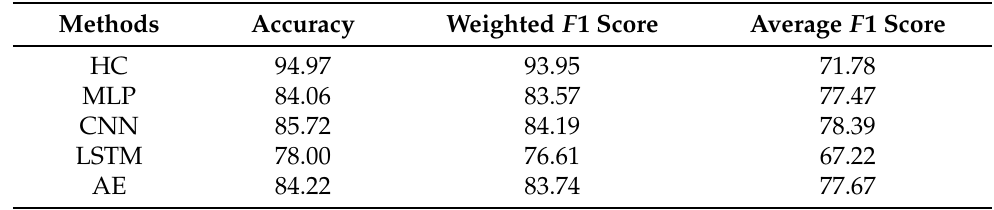
Table 5. RF classification performance metrics (in percent) of different feature extraction models of five cross on the SHRP2 data set.